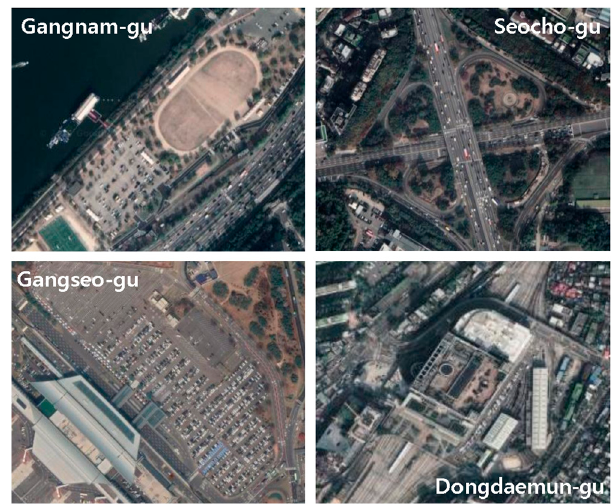
Figure 8. Examples of final 100 vertiports.